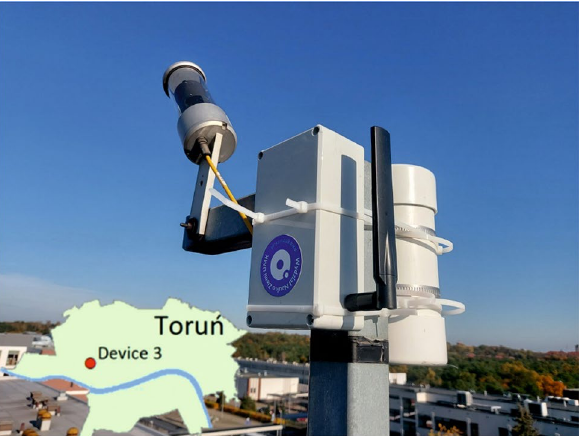
Figure 7. Device 3 located on the area of the Nicolaus Copernicus University in Toruń, next to the device is the SQM photometer (photo by Mieczysław Kunz).